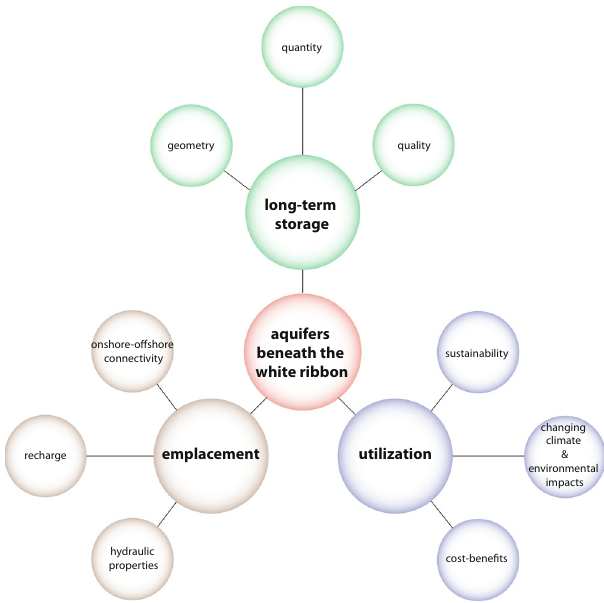
Fig. 3 Exploring deep coastal groundwater systems across space and time. Aspects of coastal aquifers that motivate future research. The three larger bubbles correspond to where does the water come from (emplacement), where is it now (long-term storage) and where is it going (utilization)? Note: similar diagrams can be drawn for other research applications (e.g., tectonics, hydrocarbons, geohazards) crossing the white